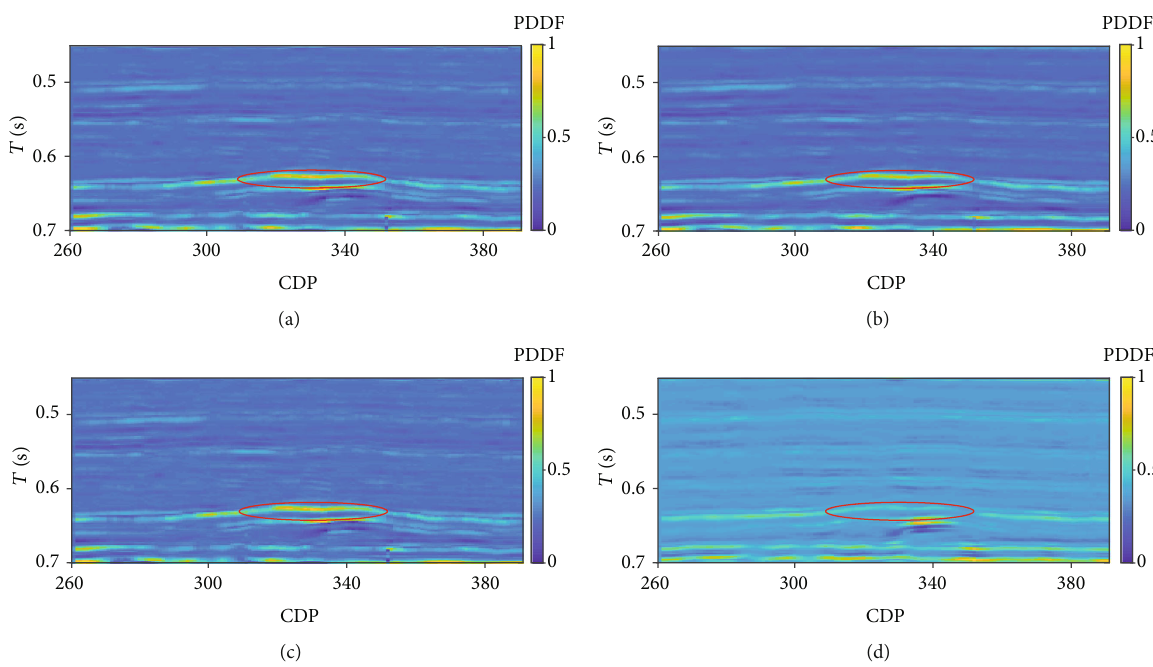
Figure 11: The P-wave di ff erence dispersion factors of di ff erent dispersion terms. PDDF indicates the P-wave di ff erence dispersion factor; (a) is the section of PDDF related to Lamé parameter, (b) is the section of PDDF related to bulk modulus, (c) is the section of PDDF related to Russell fl uid factor ( γ 2 dry = 2 : 3 ), and (d) is the section of PDDF related to P-wave velocity. The red circle highlights the location of the gas reservoir. The PDDFs are normalized.